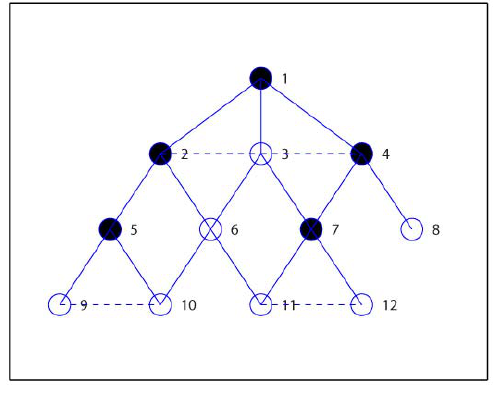
Figure 6. Remove redundant nodes in the EMCDS